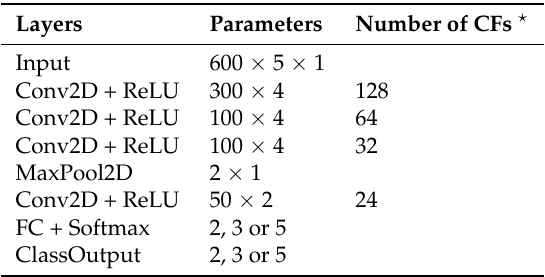
Table 3. Design of CNN for vehicle